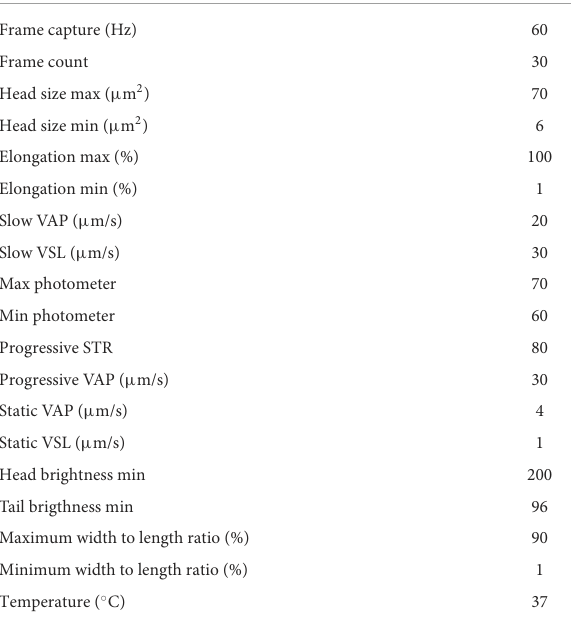
TABLE 1 Setting for goat semen